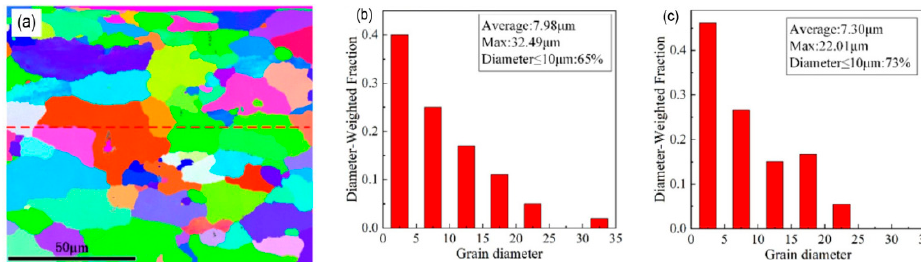
Figure 7. Statistics of grain size of aluminum alloy substrate after laser cleaning. ( a ) electron backscatter diffraction results; ( b ) entire region; ( c ) upper region [68].